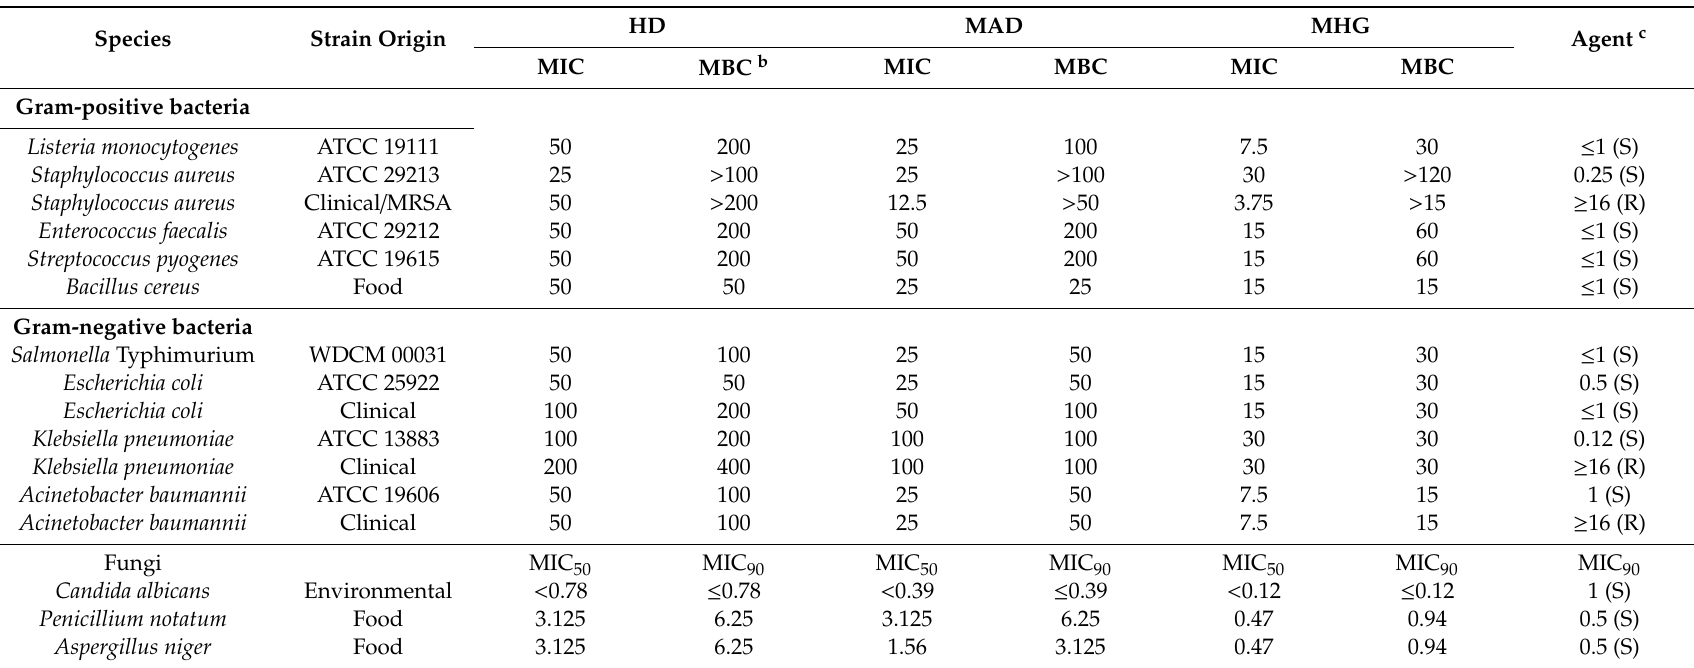
Table 3. Antimicrobial activity of horseradish ( Armoracia rusticana ) roots extract, distillates by microdilution assay a .